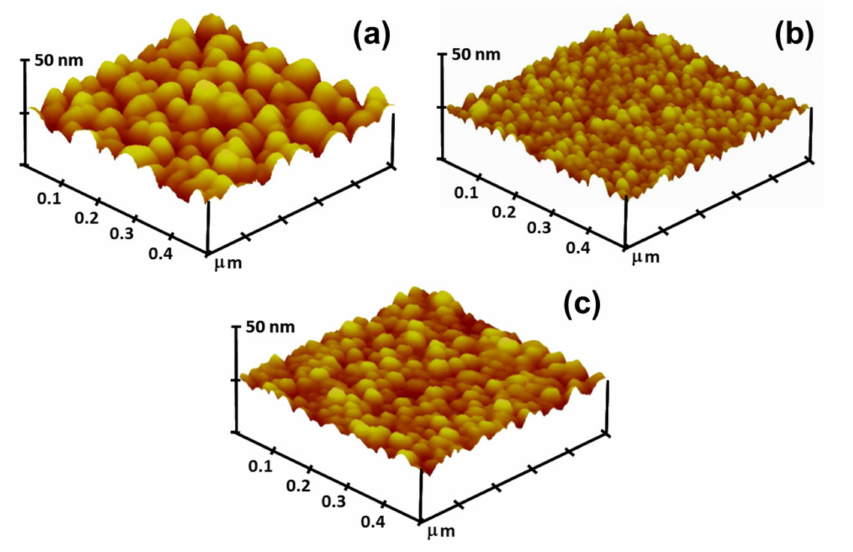
Figure 4. Surface scanning probe microscope (SPM) images of ZnO-based thin films. ( a ) ZnO; ( b ) AZO; and ( c ) GZO thin films.